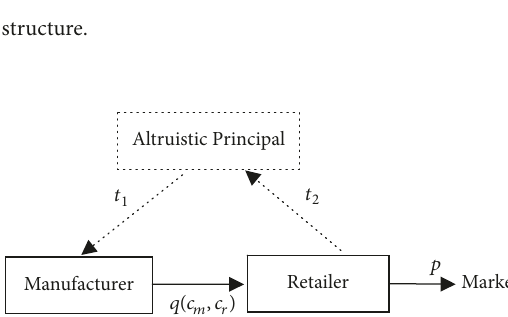
Figure 2: Supply chain structure with an altruistic